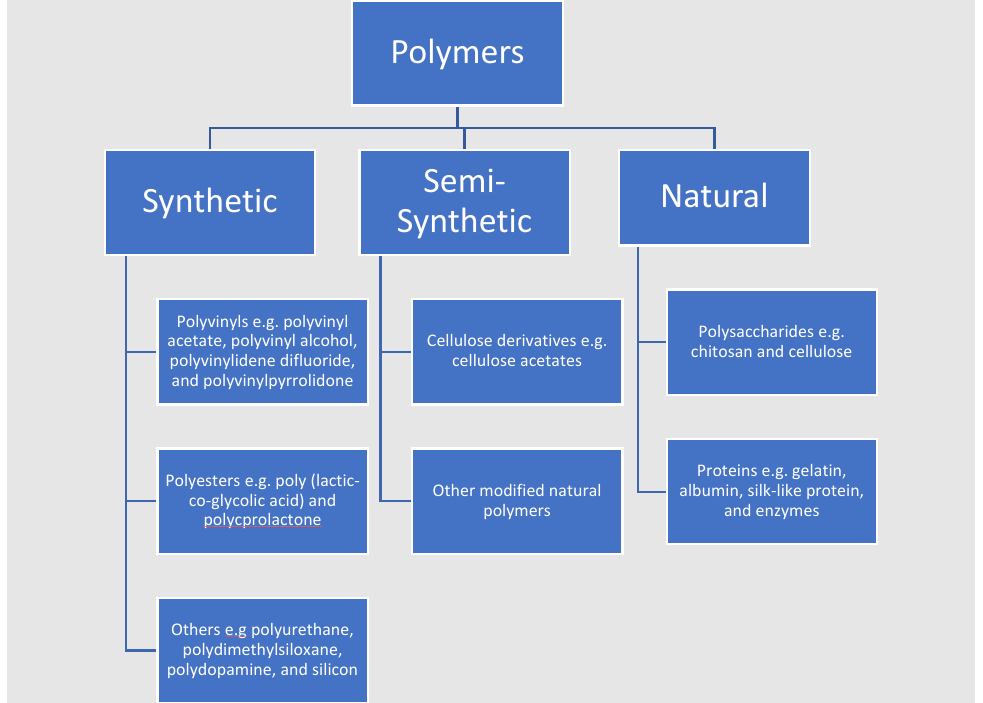
Figure 18. A scheme showing the synthetic, semi-synthetic, and natural polymers used for synthesising MOF–polymer composites for antimicrobial studies.